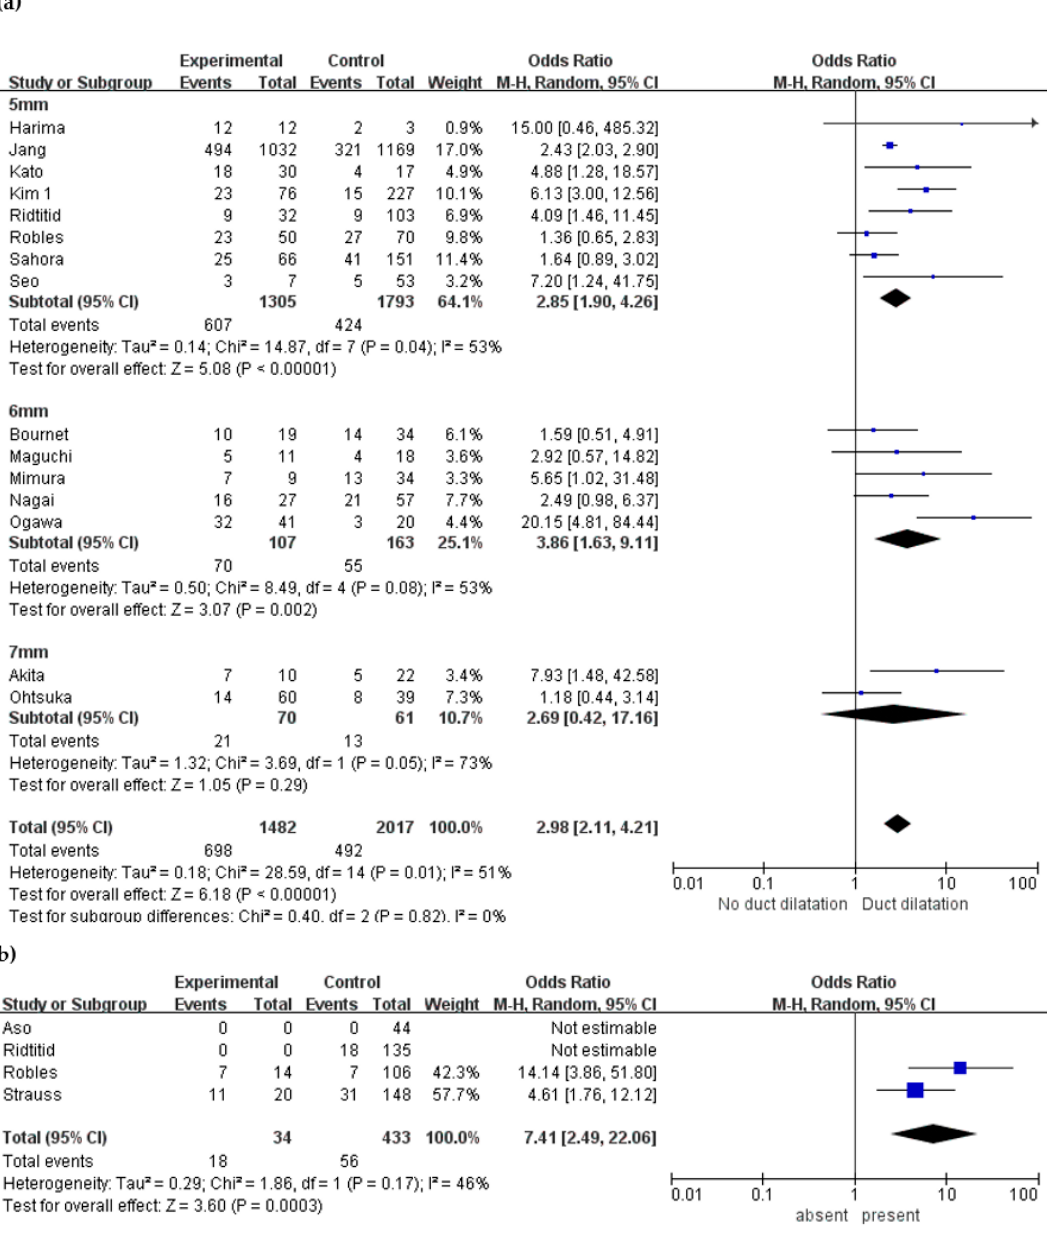
Figure 3. Forest plot demonstrates the incidence of malignancy in BD-IPMN in relation to change in main pancreatic duct. Forest plot stratified ( a ) by the diameter of pancreatic duct and ( b ) by abrupt caliber change.